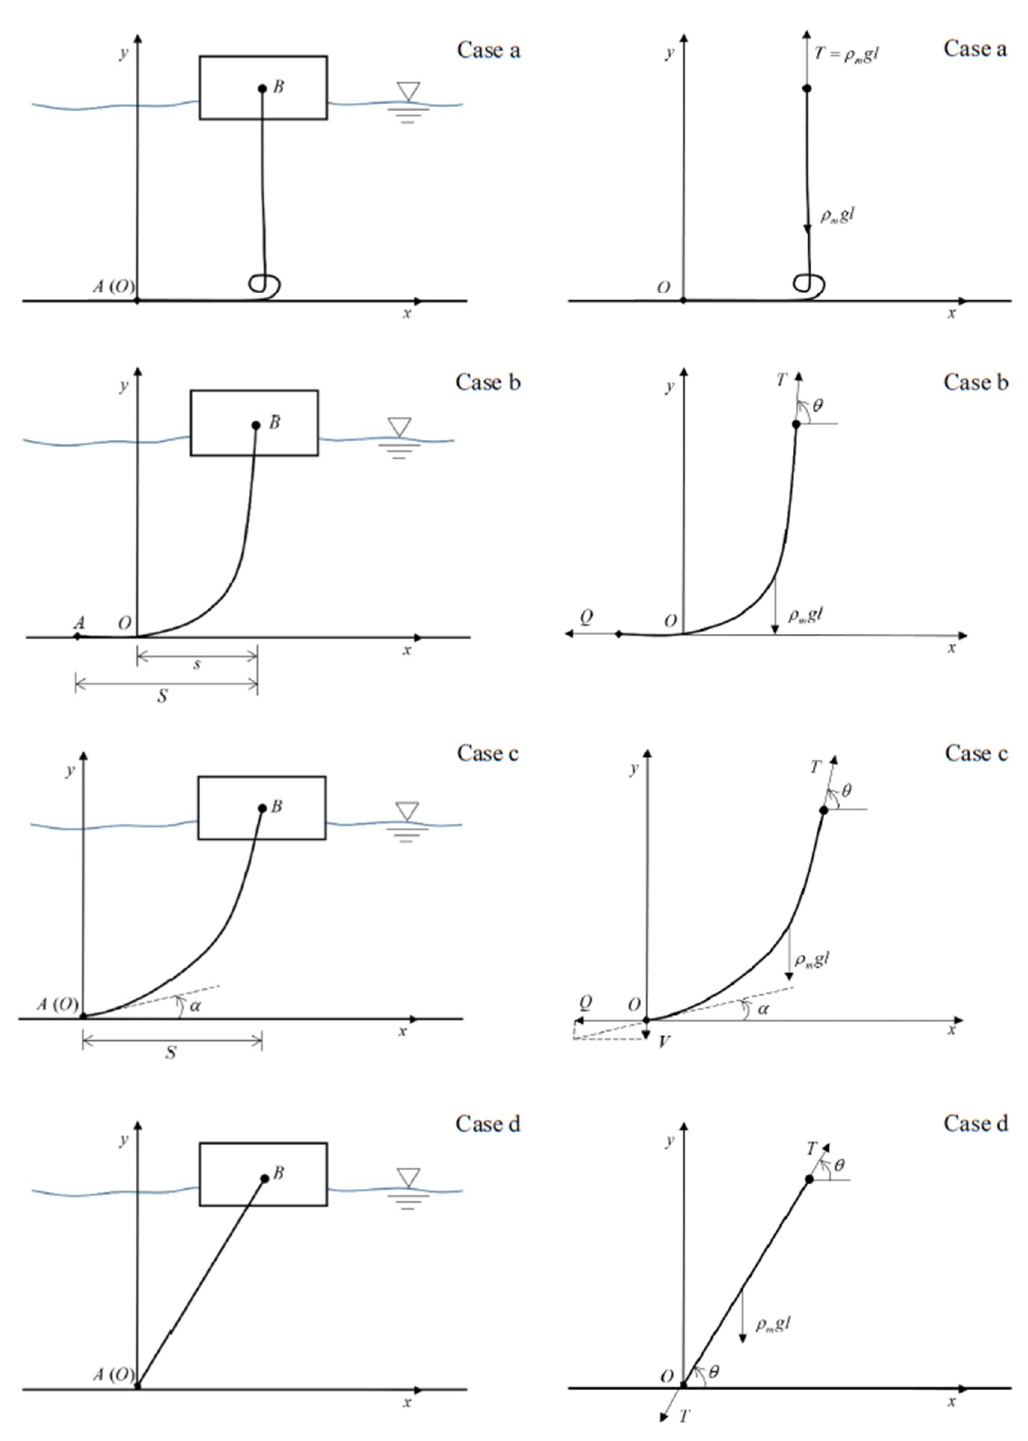
Figure 1. The illustration of a moored floating body and force analysis of a mooring line in four different states.